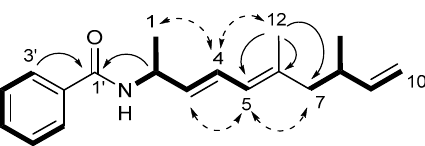
Figure 2. Key 2-demensional NMR correlations in haliamide ( 1 ). Bold lines: DQF-COSY, curve arrows: HMBC, dotted arrows: NOESY.